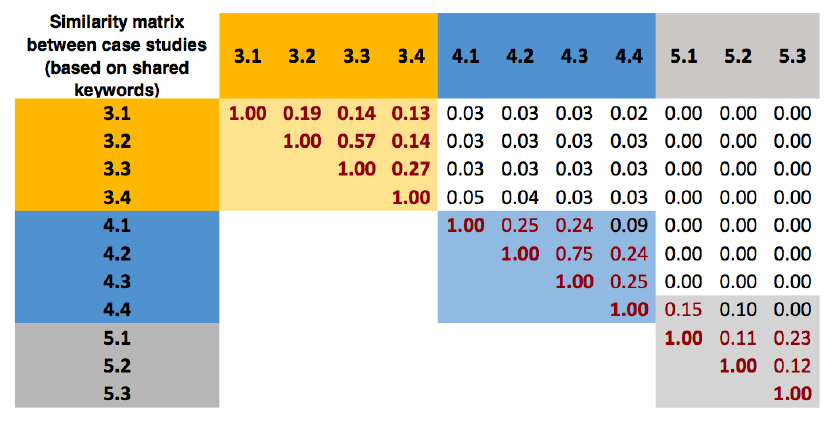
Figure 4. Jaccard similarity between study cases represented as fuzzy sets of